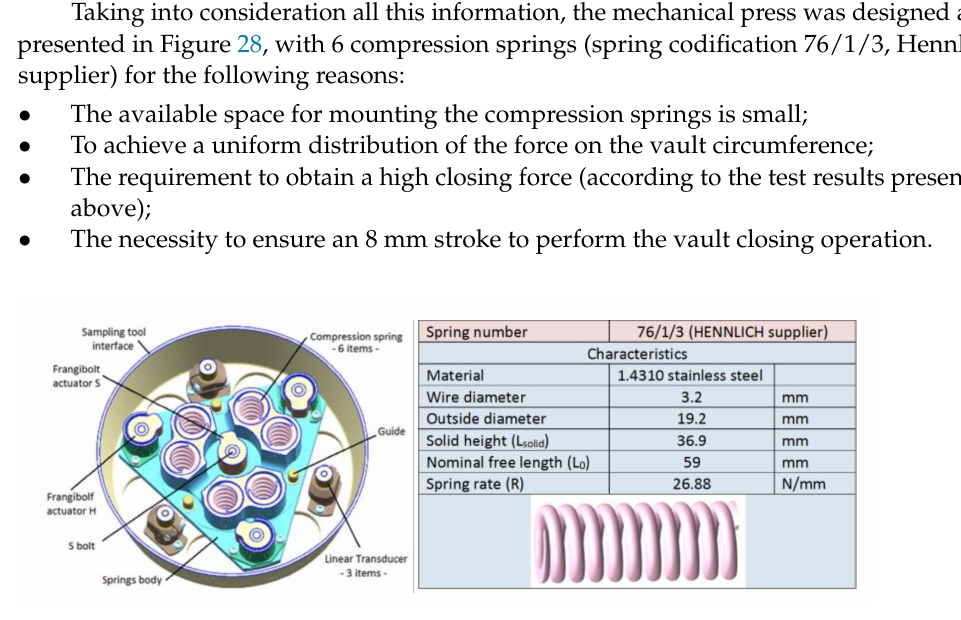
Figure 28. Mechanical press design and spring